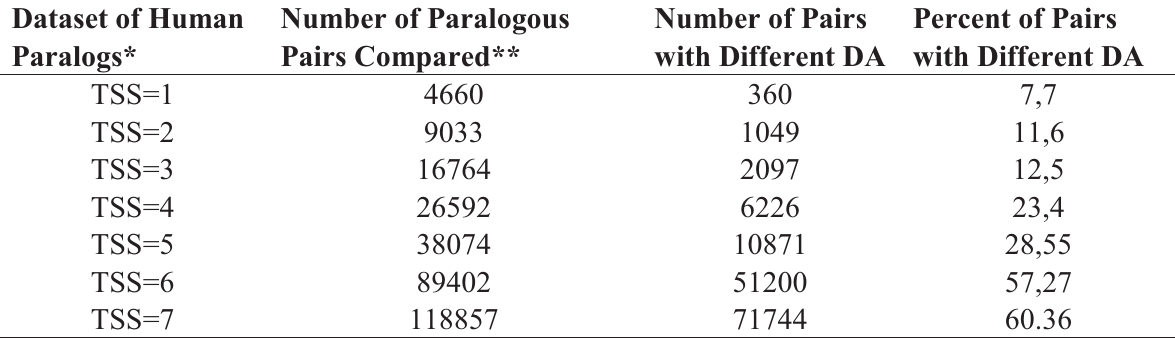
Table S2. Comparison of the DA of paralogous human Swiss-Prot proteins defined through comparison of human Swiss-Prot